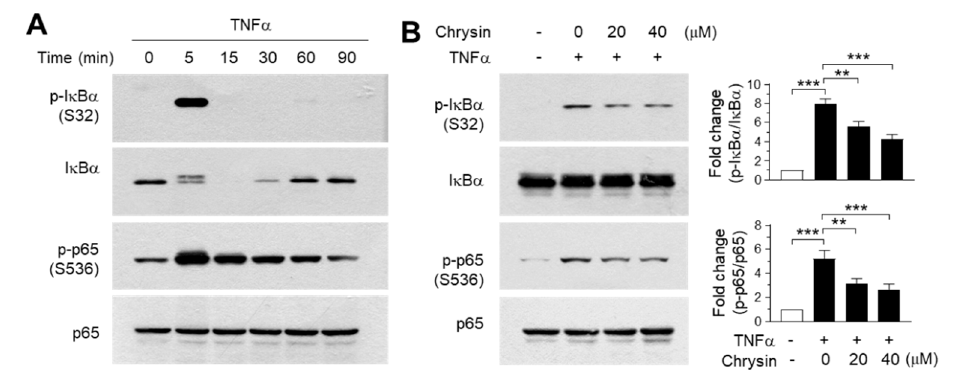
Figure 4. Effect of chrysin on the inhibition of the downstream signaling pathway of the inhibitor of κ B (I κ B) kinase (IKK). ( A ) HaCaT cells were treated with 10-ng/mL TNF α for different periods (0–90 min), and the phosphorylation of I κ B at Ser32 and p65/RelA NF- κ B at Ser536 were observed in immunoblotting experiments. Total I κ B and p65 proteins were used as the internal controls. ( B ) HaCaT cells were pretreated with chrysin (20 and 40 μ M) for 30 min, then stimulated with 10-ng/mL TNF α for 5 min. The phosphorylation of I κ B and p65/RelA NF- κ B were measured by immunoblot analysis. The band intensity corresponding to each phosphorylated protein was normalized to the total protein levels for each protein using ImageJ software. The bars represent mean ± SD ( n = 3). ** p = 0.0005 and *** p < 0.0001 by Dunnett’s multiple comparisons test.